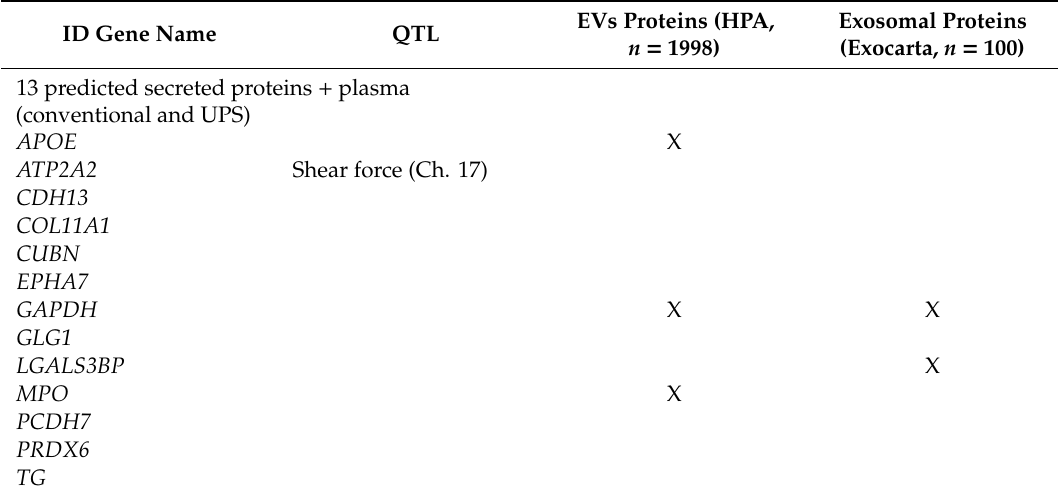
Table 2. List of the 71 candidate plasma proteins associated with beef